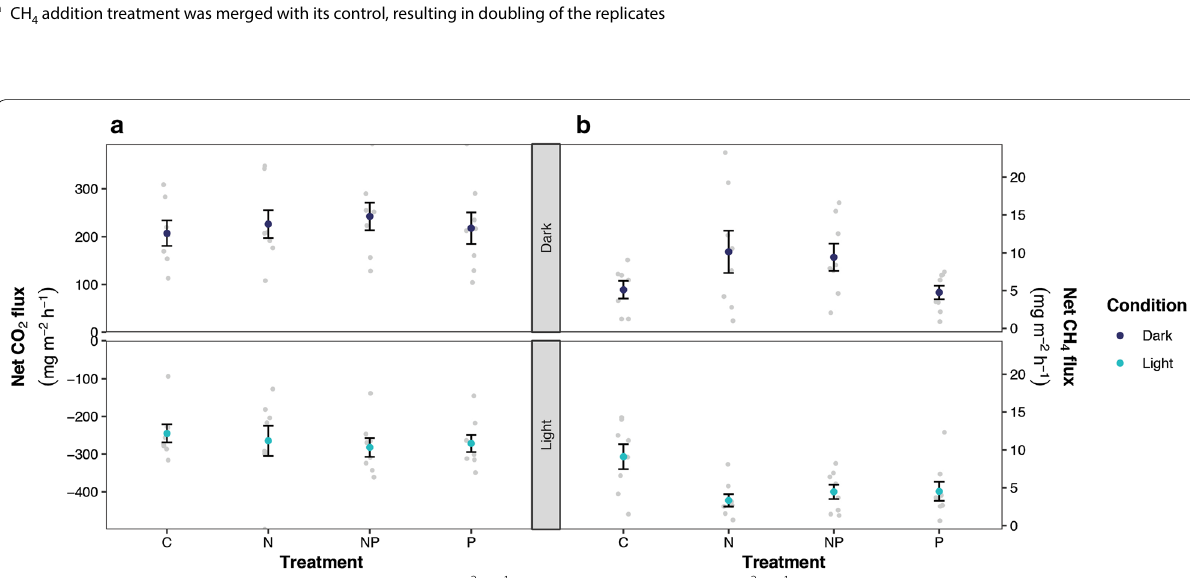
ns not significant a CH 4 addition treatment was merged with its control, resulting in doubling of the replicates